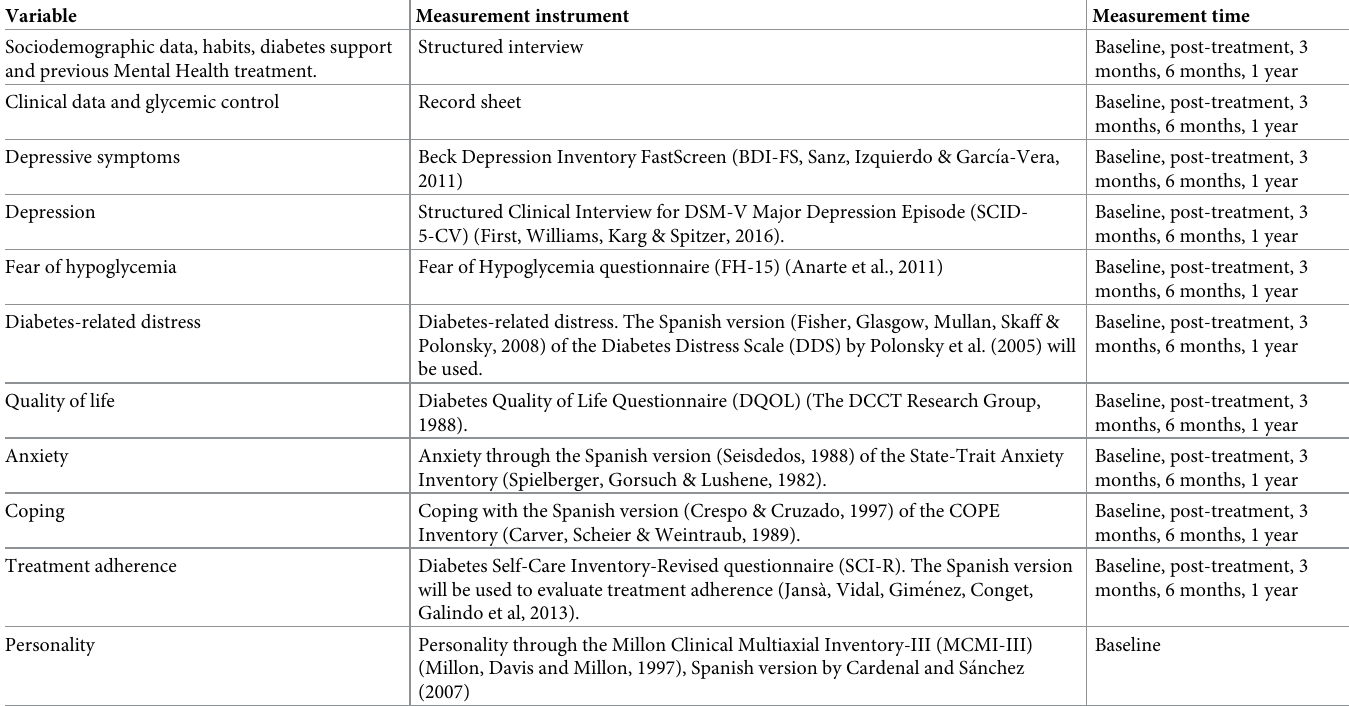
Table 2. Variables evaluated in the